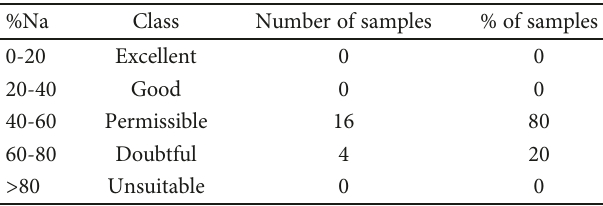
Table 8: Irrigation quality of groundwater based on sodium